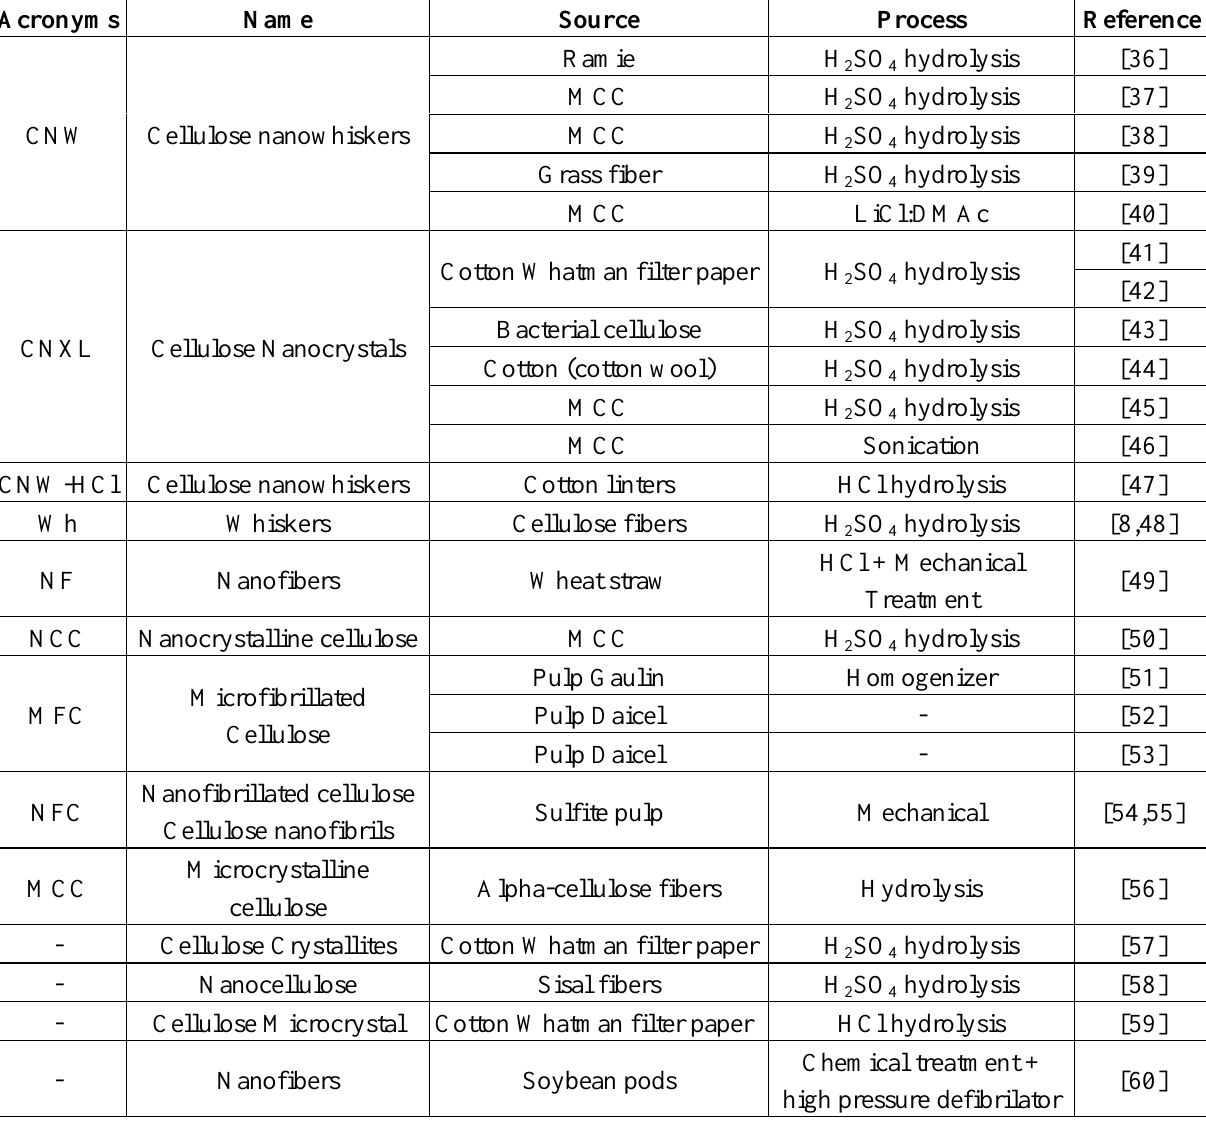
Table 3. The different terminologies used to describe cellulose